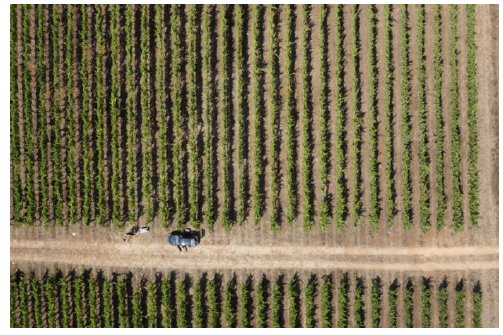
Figure 7. Partial RGB orthophoto